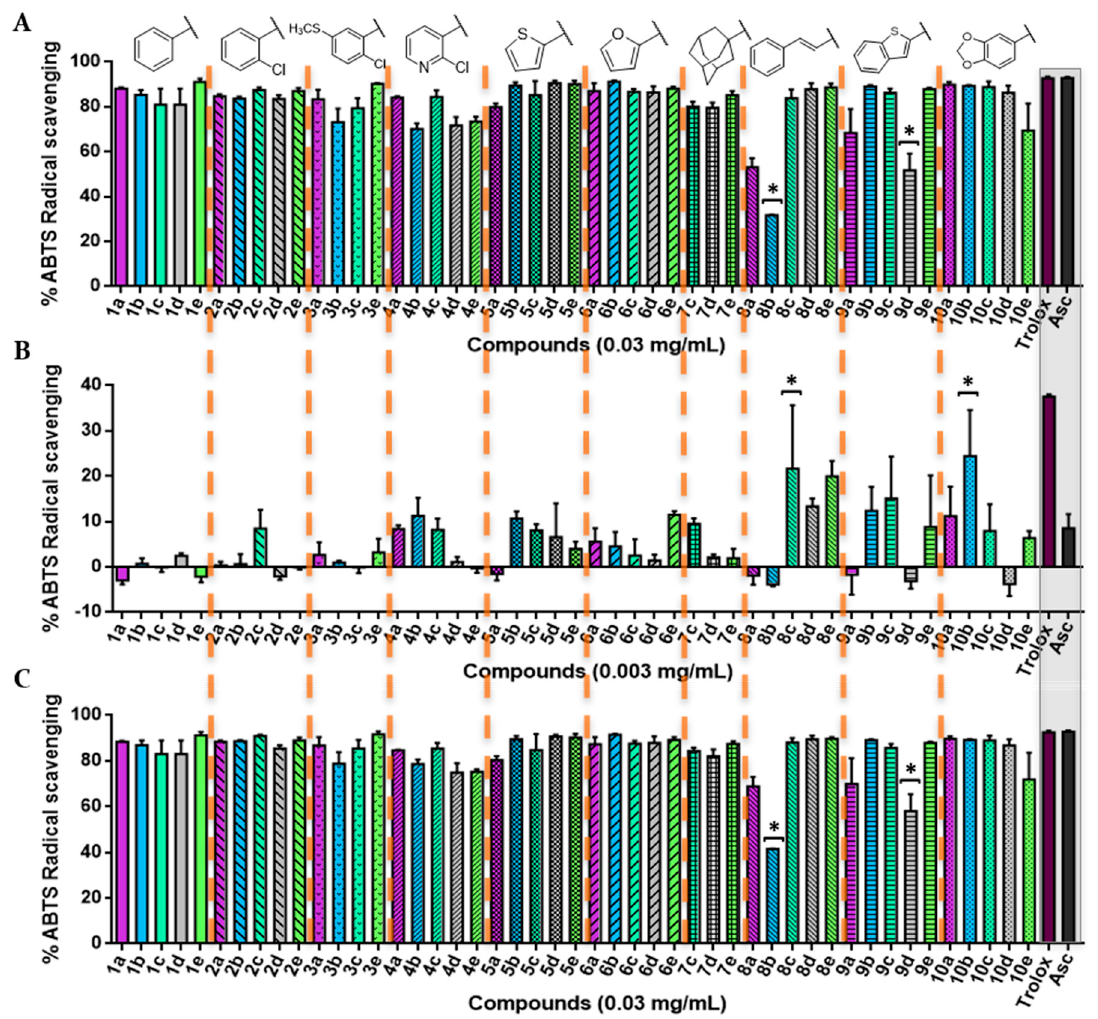
Figure 4. 2,2 ′ -azino-bis(3-ethylbenzthiazoline-6-sulfonic acid) (ABTS) radical scavenging activity of the novel acylselenourea compounds. ( A ) Percentage of ABTS +• scavenging after 0 min at the highest concentration tested (0.03 mg/mL); ( B ) percentage of ABTS +• scavenging after 0 min at 0.003 mg/mL; ( C ) percentage of ABTS +• scavenging at 0.03 mg/mL after 6 min of incubation for all the 47